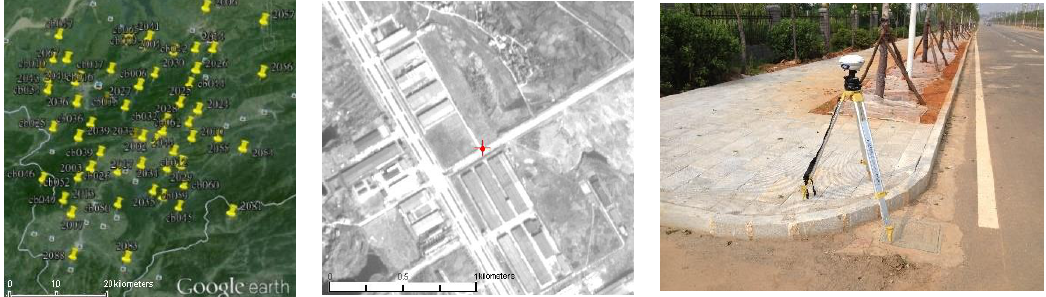
Figure 2. Distribution map of GCPs in the Xianning test filed.